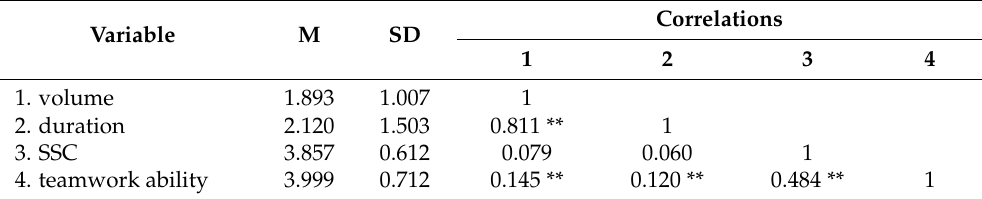
Table 1. Descriptive Statistics and Correlations.